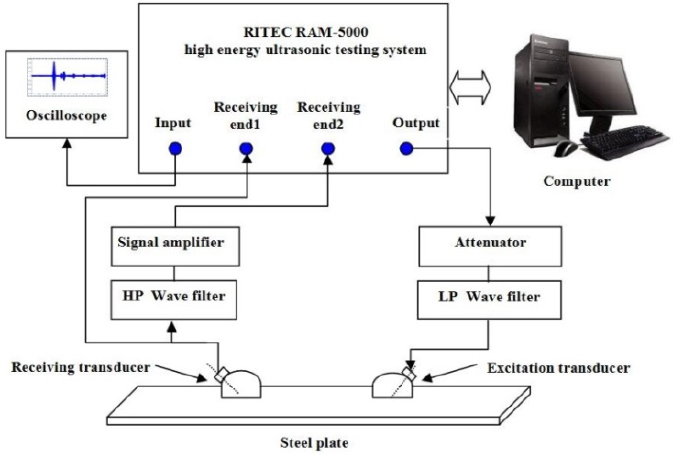
Figure 9. The experimental system’s diagram.